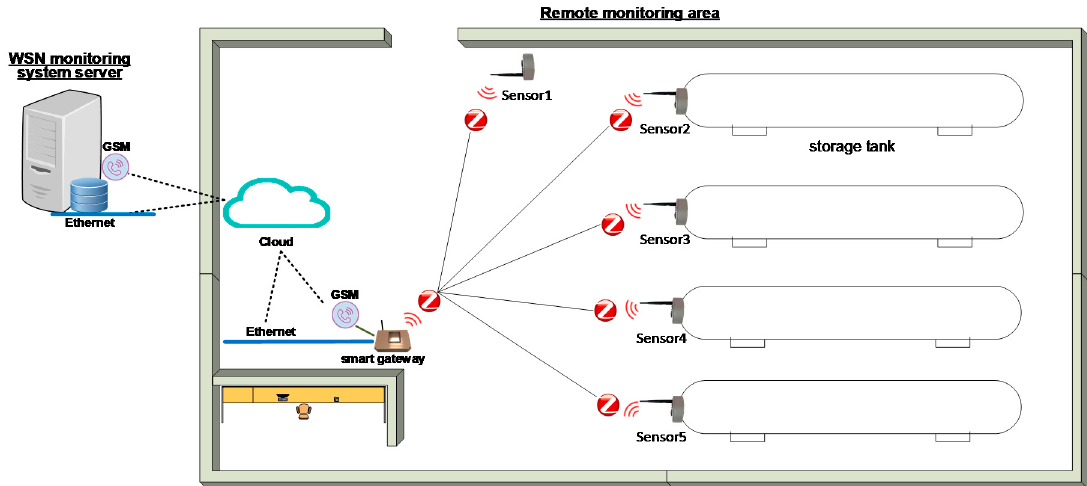
Figure 10. The system implementation architecture.